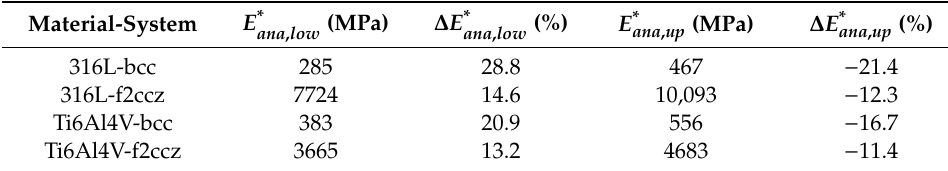
Table 8. Tolerance interval boundaries of the analytical